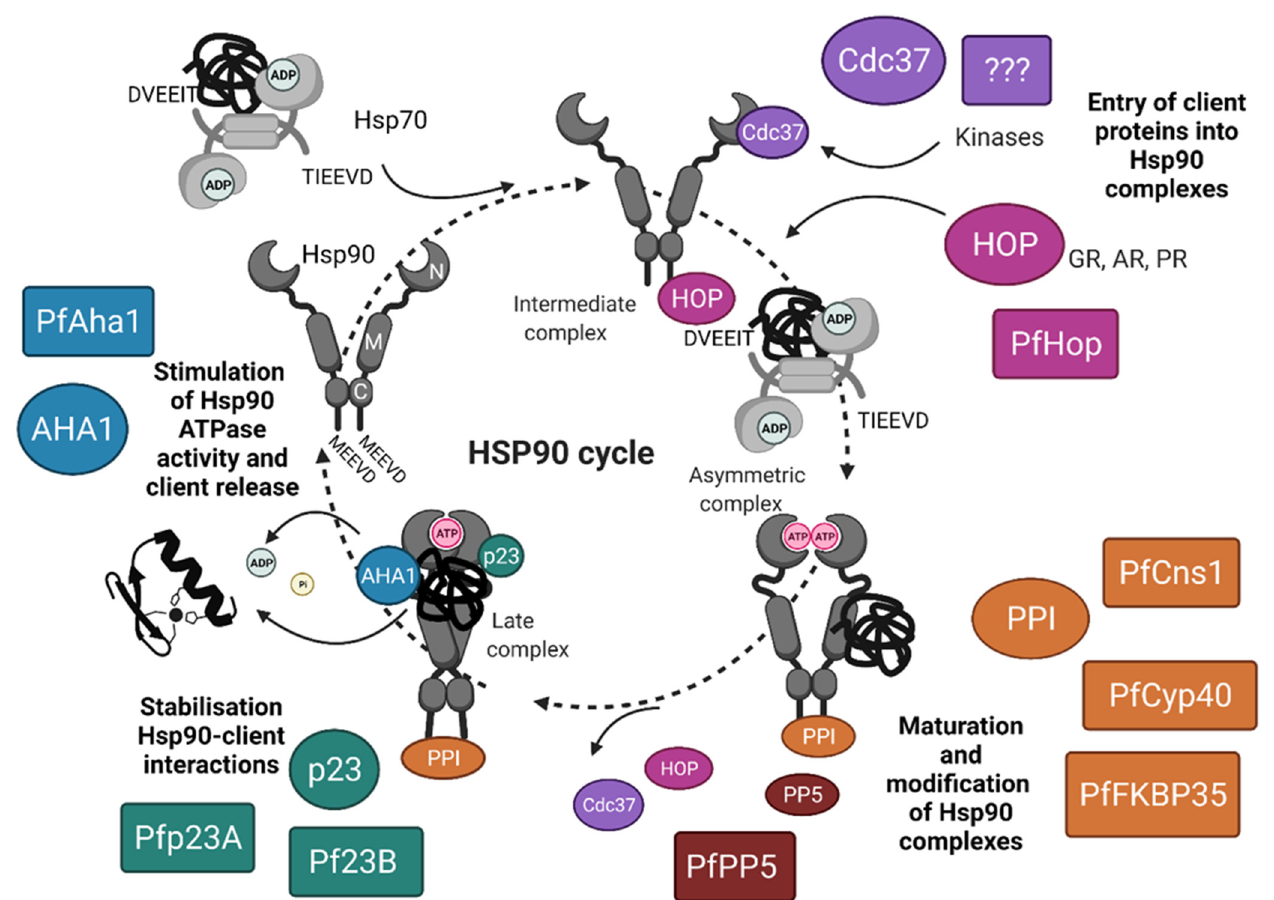
Figure 1. Regulation of the Hsp90 chaperone cycle by co-chaperones. Progression of client proteins through the Hsp90-mediated chaperone folding pathway is regulated by co-chaperones, which act at defined stages in the cycle. Co-chaperones may regulate Hsp90 association with clients, ATPase activity, conformational changes, and post-translational modifications. When inactive, Hsp90 is constitutively dimerized at the C-terminus but not the N-terminus. Entry of client proteins is facilitated by co-chaperones including the Hsp70/Hsp90 organizing protein Hop, which regulates transfer of clients from Hsp70 by binding simultaneously to Hsp70 and Hsp90, to form the intermediate complexes. Hop is conserved in Plasmodium falciparum (PfHop, PF3D7_1434300). Kinase clients require the kinase-specific co-chaperone Cdc37; however, a Cdc37-encoding gene has not been identified in the P. falciparum genome. On ATP binding, Hsp90 undergoes N-terminal dimerization, and the client protein associates with the middle domain of Hsp90. Bindings of other co-chaperones, including peptidyl-prolyl cis–trans isomerases (PPIase) and protein phosphatase 5 (PP5), associate to form the asymmetric Hsp90 complexes. The P. falciparum genome encodes a PP5 isoform (PfPP5, PF3D7_1355500) and multiple PPIase isoforms (PfFKBP35, PF3D7_1247400; PfCns1, PF3D7_1108900; and PfCyp40, PF3D7_1111800). These co-chaperones regulate the post-translational modification and maturation of Hsp90 complexes. Early co-chaperones subsequently dissociate from the complex to be replaced by p23, which stabilizes the late closed Hsp90 complex and the client within the complex, and inhibits ATPase activity. Two homologs of p23 are encoded in the P. falciparum genome (Pfp23A, PF3D7_1453700; and Pf23B, PF3D7_0927000). ATP hydrolysis is stimulated by binding of Aha1, resulting in release of the client protein and a return of Hsp90 to the inactive conformation. The P. falciparum genome encodes a single Aha1 isoform (PfAha1, PF3D7_0306200). Image created with